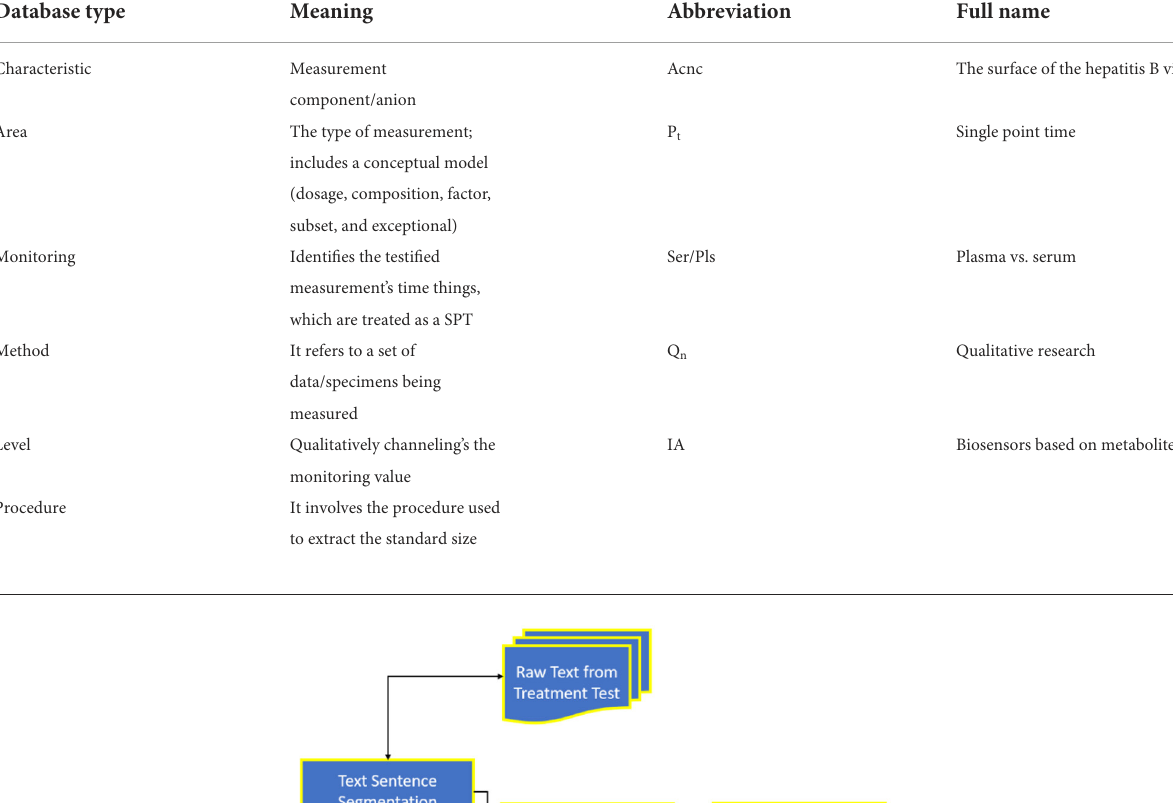
TABLE 1 Summary of database and LOIN code.